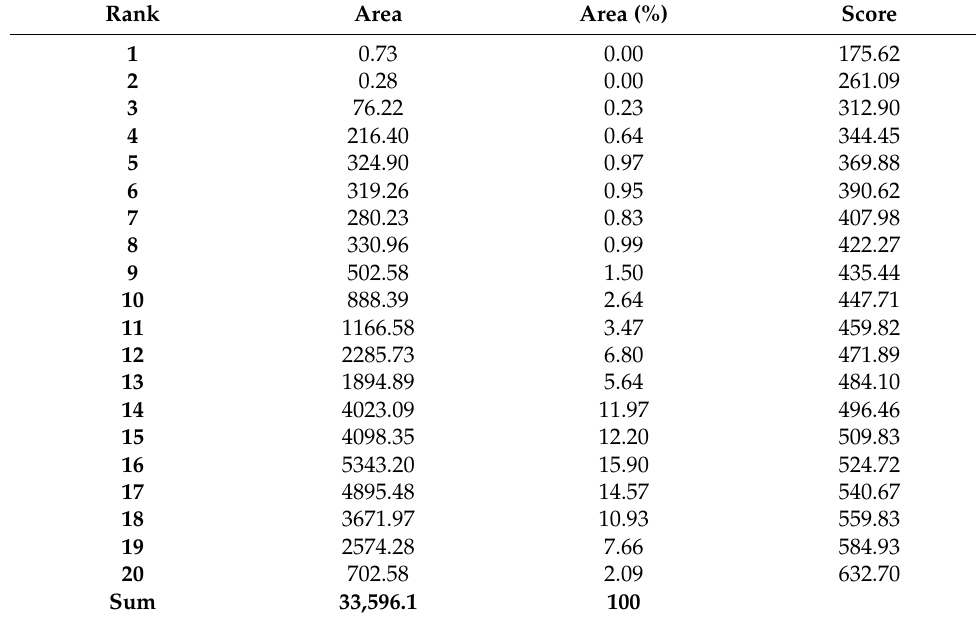
Table 6. Areas of suitability map classes based on AHP detailed in 20